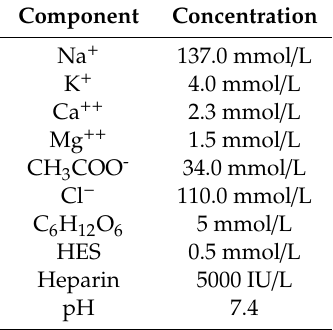
Table 1. Composition of the modified hydroxyethyl starch solution used as perfusion and flushing solution.